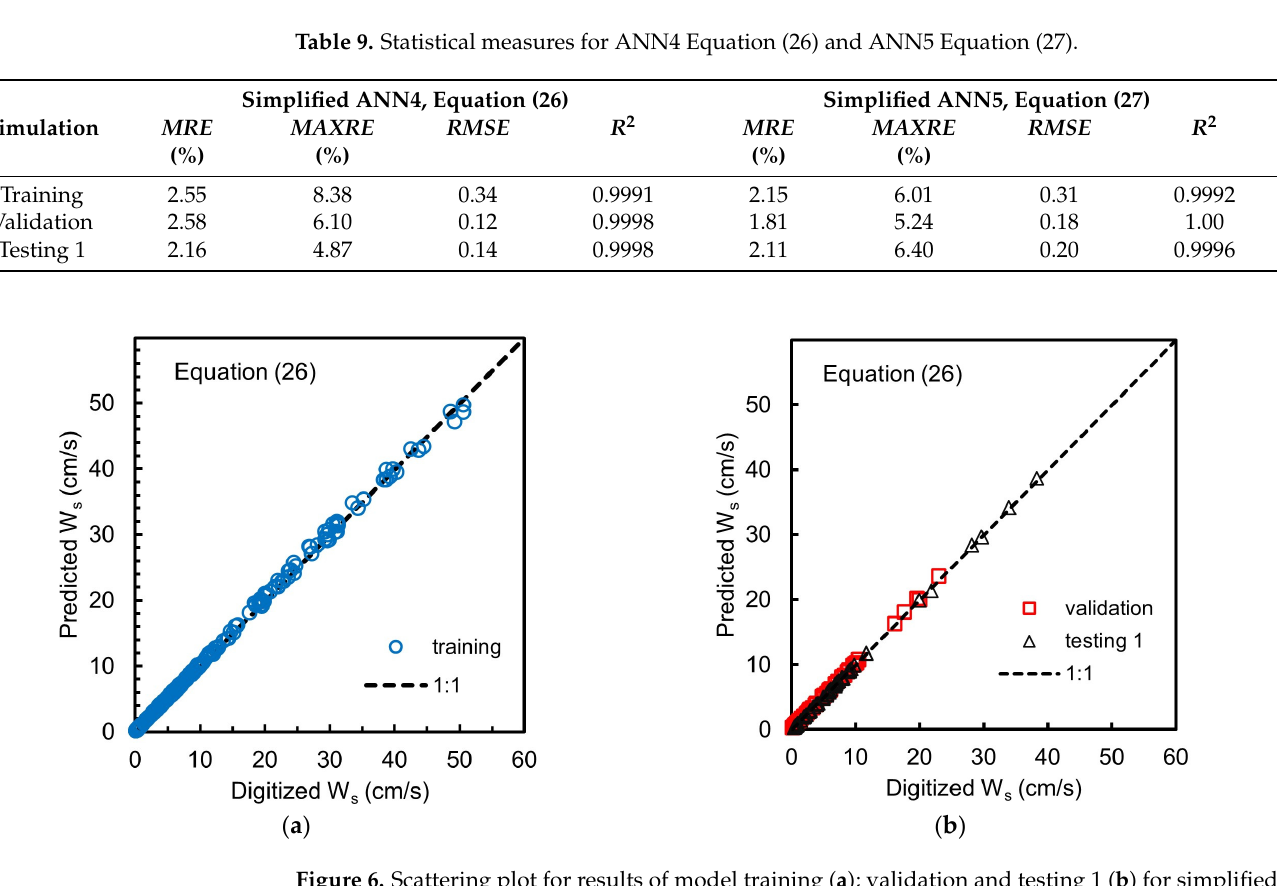
Figure 7. Scattering plot for results of model training ( a ); validation and testing 1 ( b ) for simplified ANN5, Equation (27).